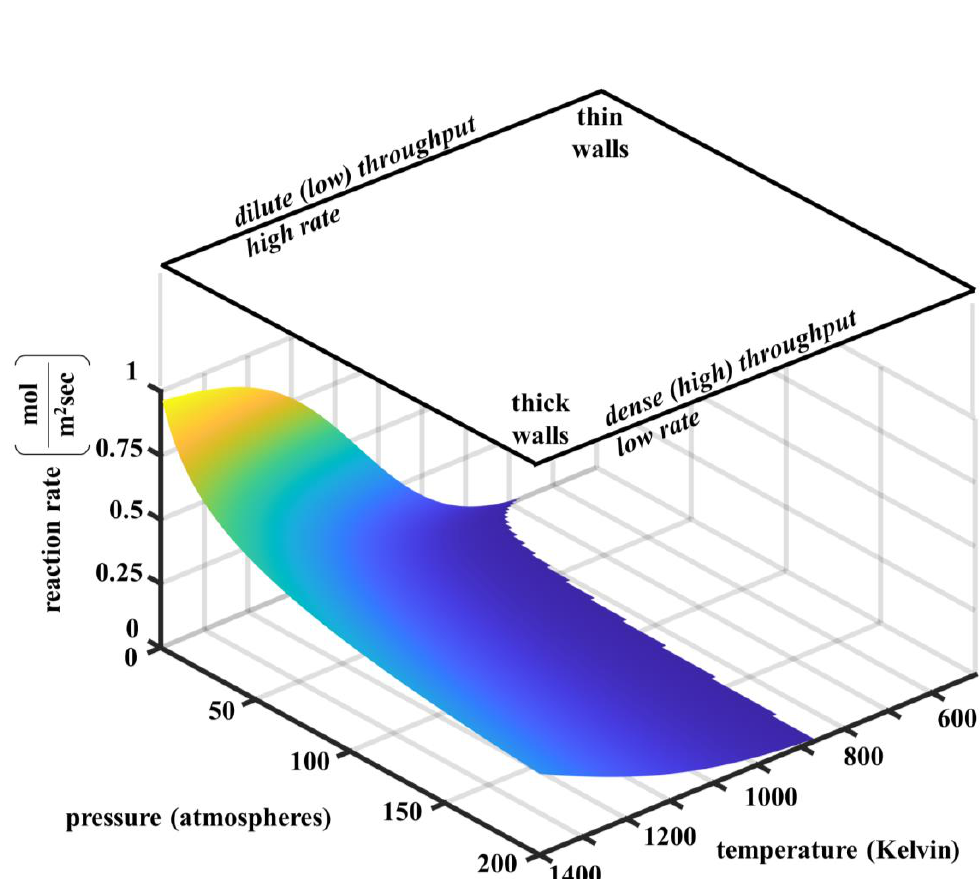
Figure 5. Reactor design implications given reversible catalytic molten methane cracking.